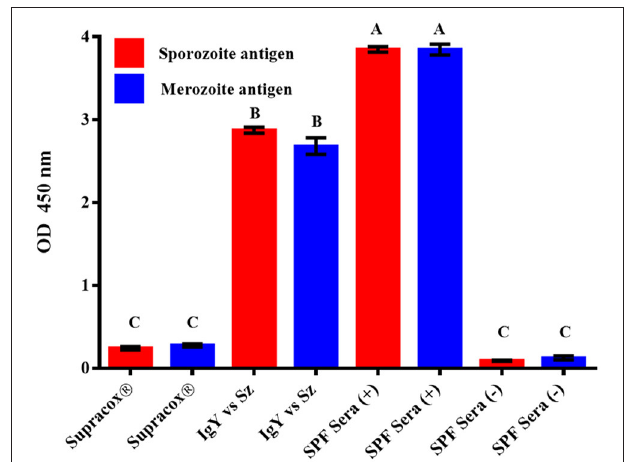
FIGURE 4 | Reactivity of the IgYs in Supracox ® , polyclonal egg yolk IgYs from birds immunized with the whole E. tenella sporozoites (IgY vs. Sz), positive antisera [SPF Sera ( + )], and negative sera [SPF Sera (–)] to sporozoite (Sz) and merozoite (Mz) antigens in ELISA. Sera from unimmunized SPF White Leghorn birds did not show any reactivity to sporozoite and merozoite antigens. Each bar represents the arithmetic mean ± standard deviation of absorbance units (O.D.) ( n = 6) of two independent observations (sera at 1:100). Bars that are not denoted by the same letter (A–C) represent significantly different values ( P < 0.05) according to Tukey’s multiple range